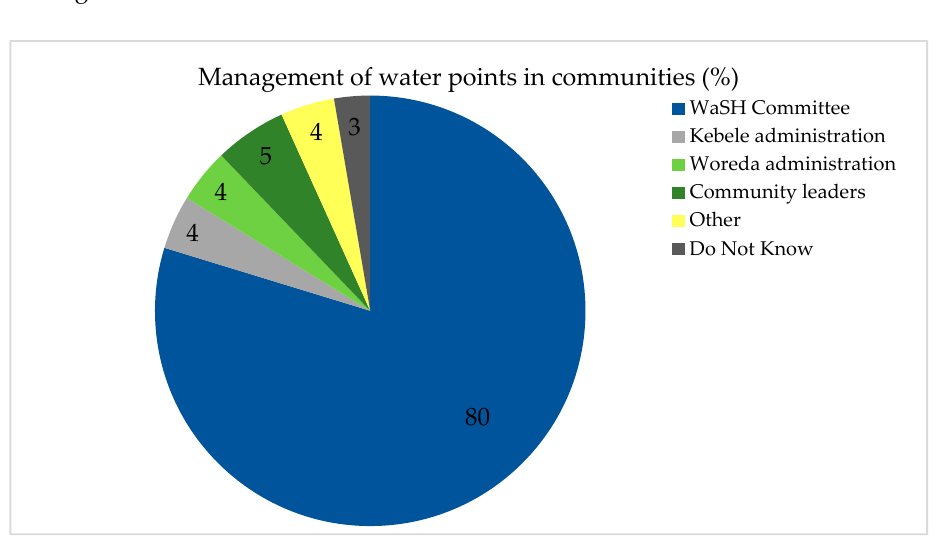
Figure 2. Management of water points in communities.